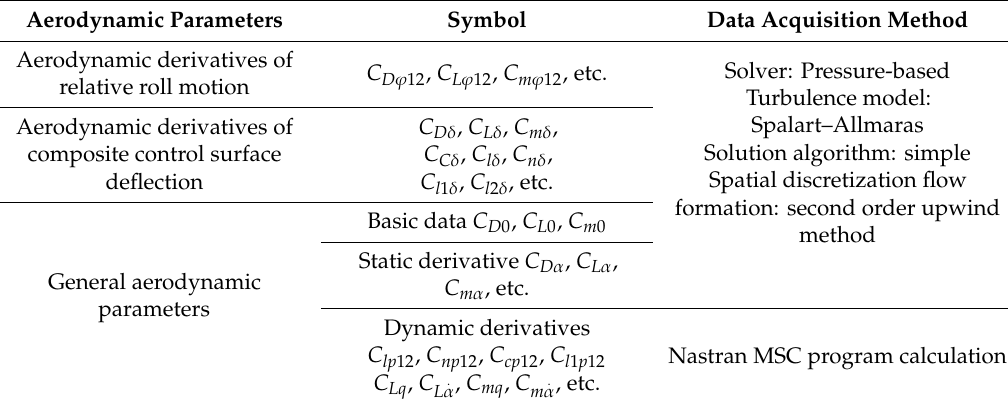
Figure 7. Wingtip-jointed aircraft system unstructured grid. Table 2. Aerodynamic database acquisition